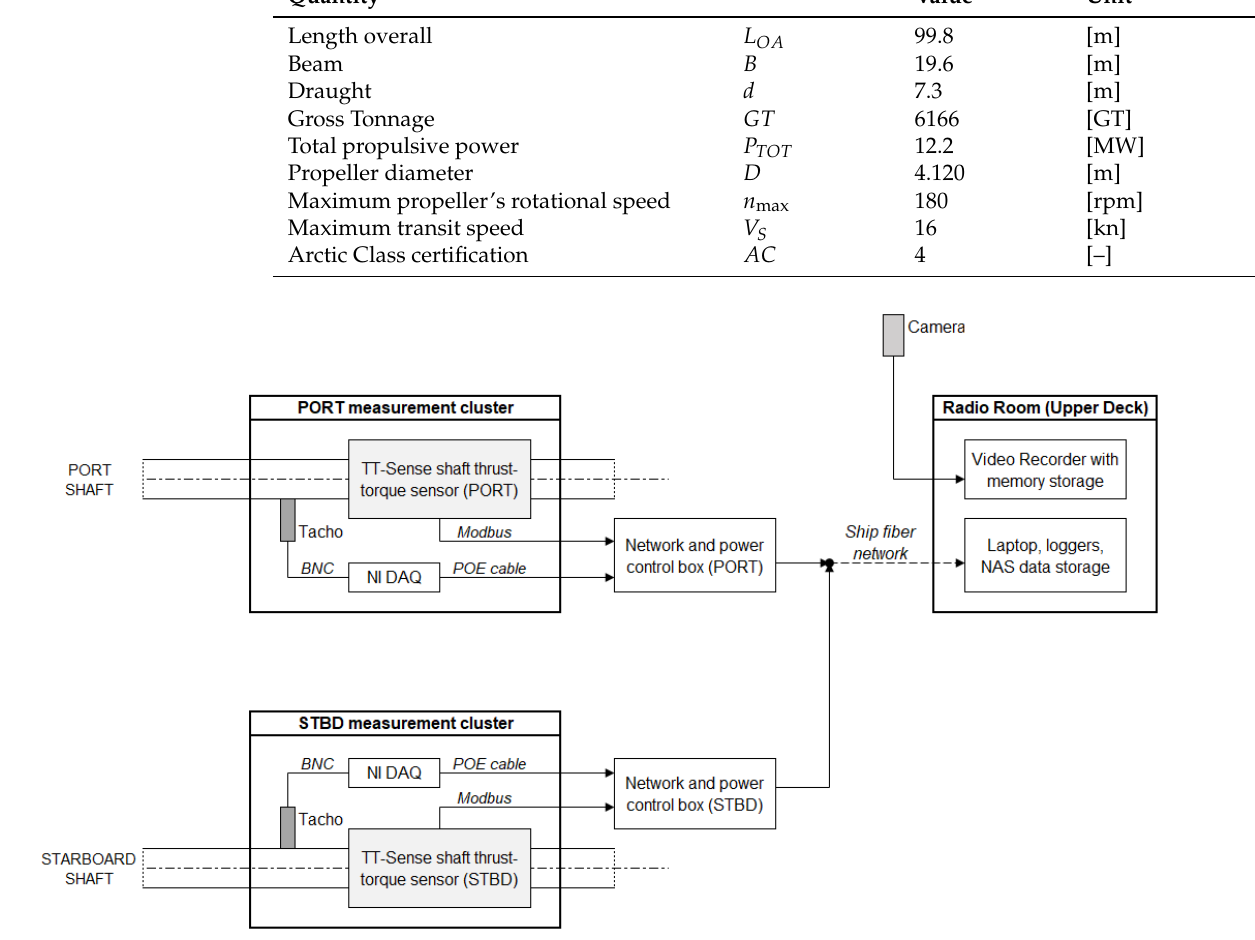
Figure 1. Layout map of the measurement system installed on board CCGS Henry